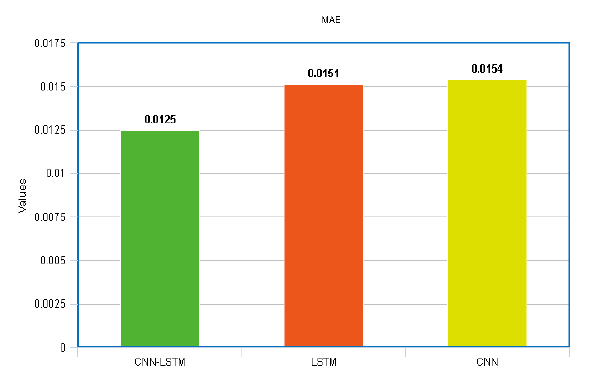
Figure 13. MAE comparison on VEDL